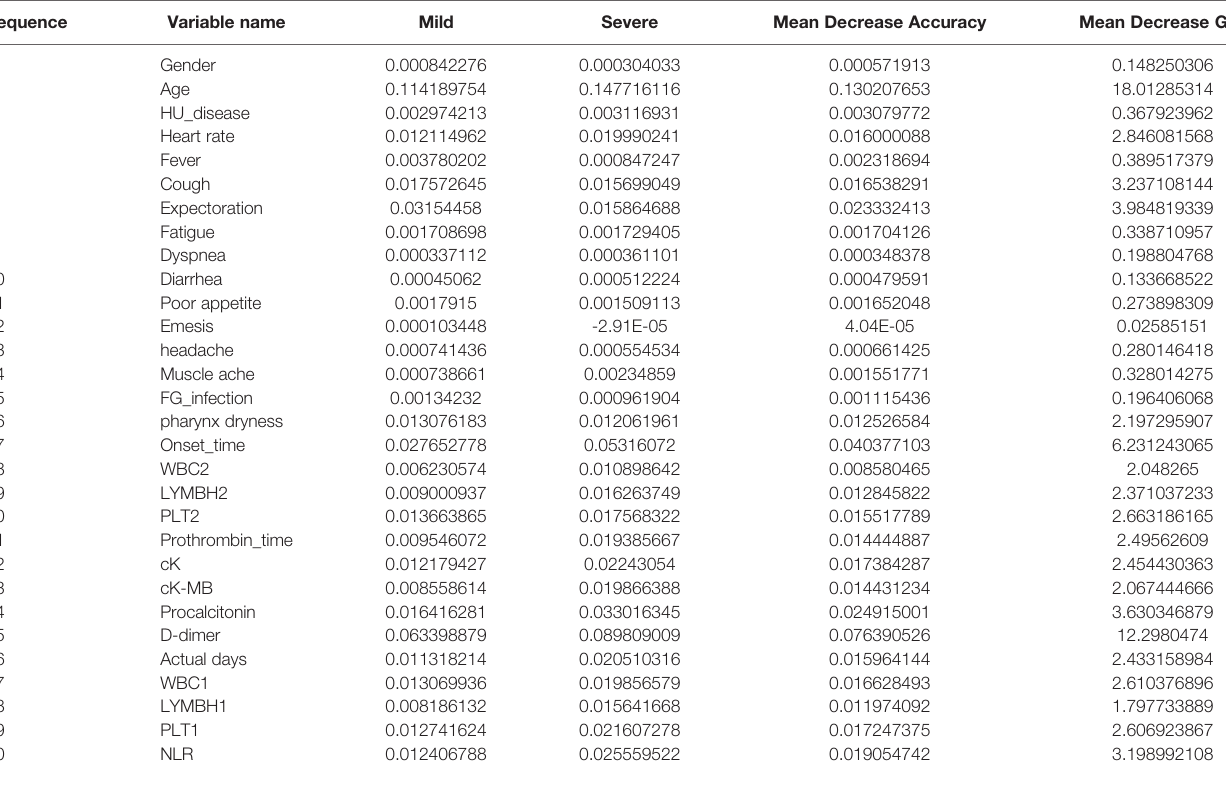
TABLE 6 | Importance of